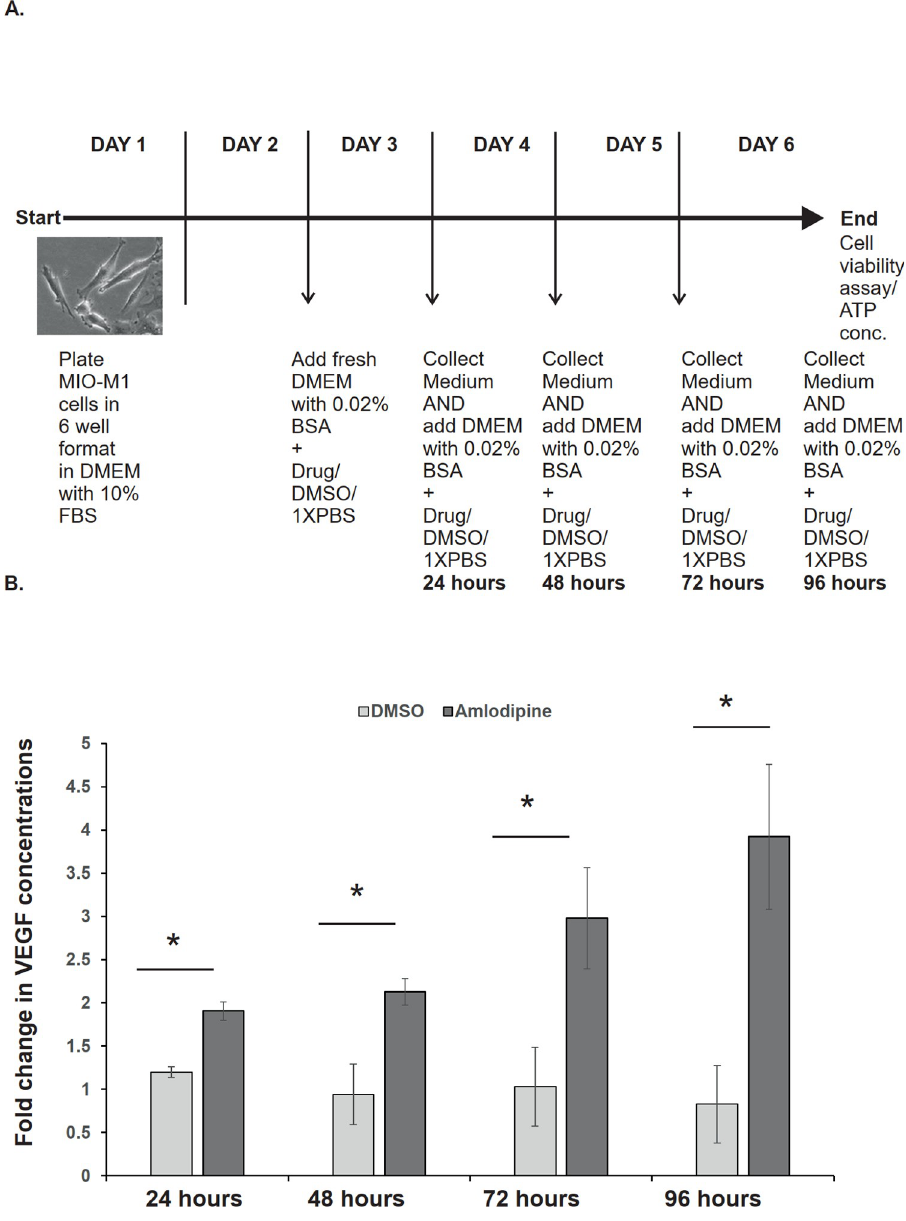
Fig 1. A: Schematic diagram showing the experimental setup and the sample collection timeline. B: Vertical bars represent the mean and the standard deviation of fold changes in the VEGF concentrations in the MIO-M1 cell culture medium at different time points (24 hours, 48 hours, 72 hours and 96 hours) after treatment with amlodipine (10 μ M) vs control. Fold changes in the VEGF concentration are calculated by dividing the concentration at a timepoint by the mean control concentration of 125.8765 pg/ml. * P-value = 0.007937.